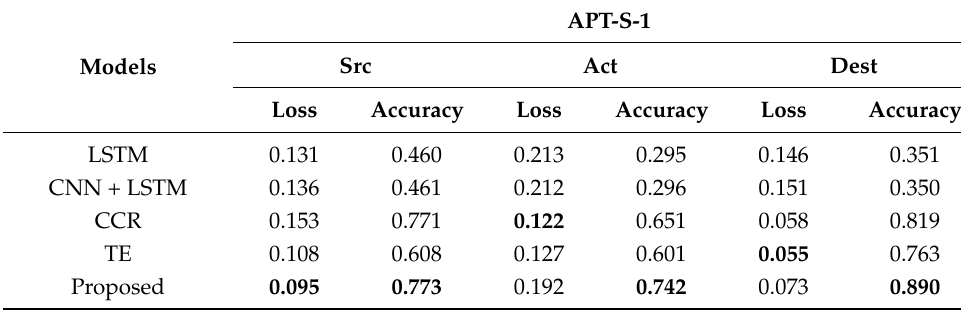
Table 3. Performance based on APT-S-1 and evolving graph.